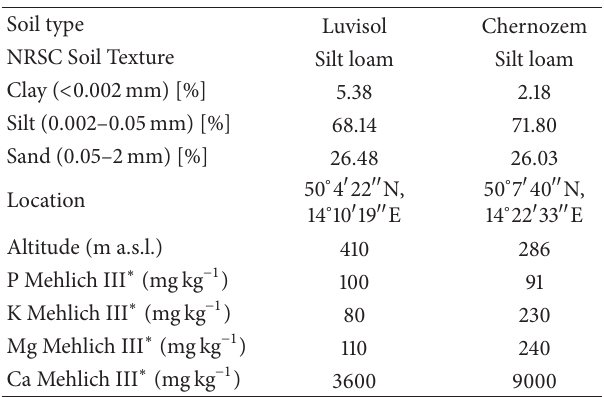
Table 1: Main physicochemical characteristics of the experimental